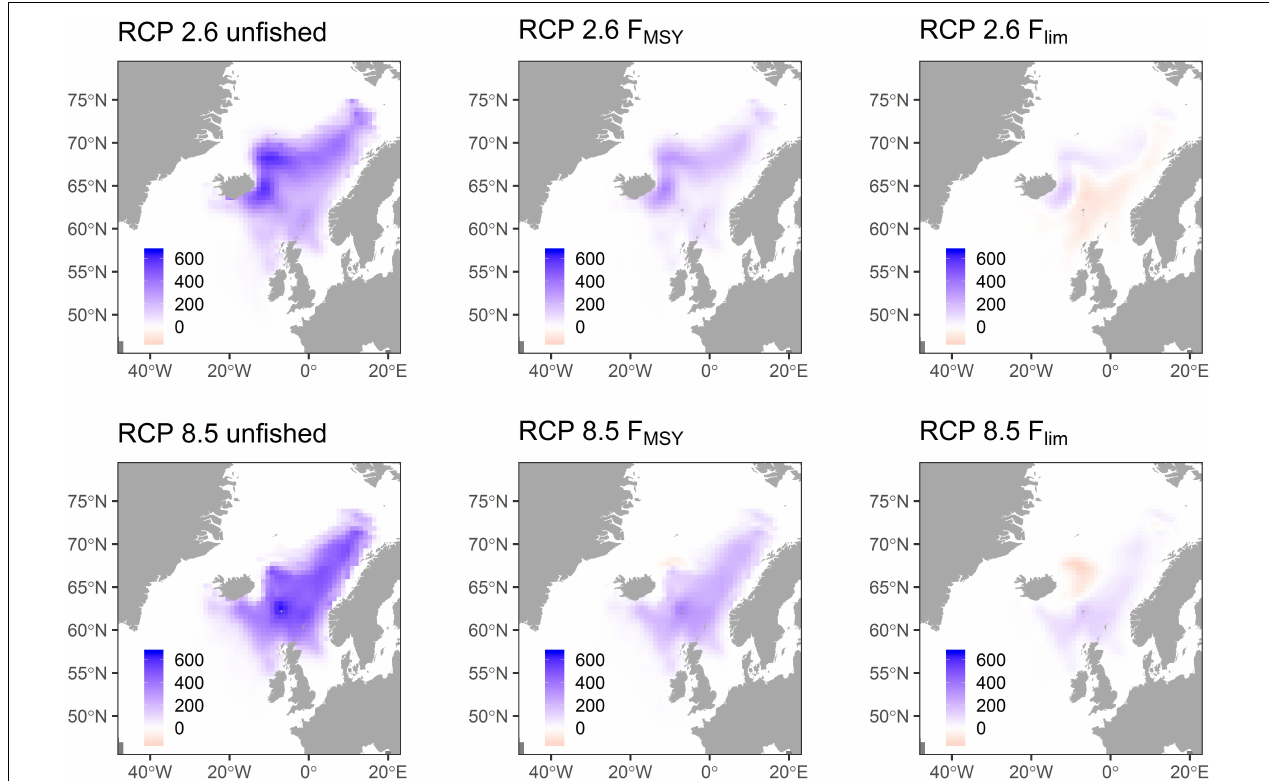
FIGURE 4 | Change in mean mackerel density (tonnes km − 2 ) between the start and end of a simulation for scenarios 1–6 ( Table 2 ). Start is taken as the mean over 2005–2010, and end as the mean over 2045–2050.